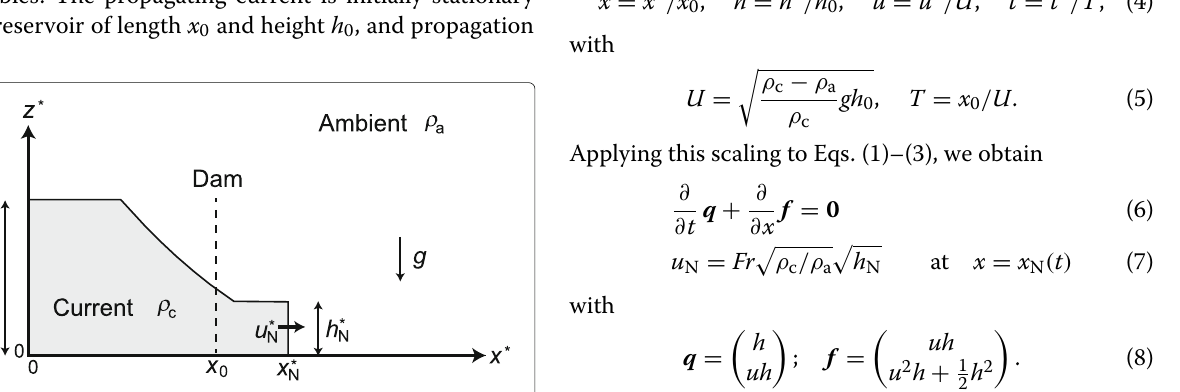
Fig. 1 Schematic of the gravity current released from a dam in a deep ambient